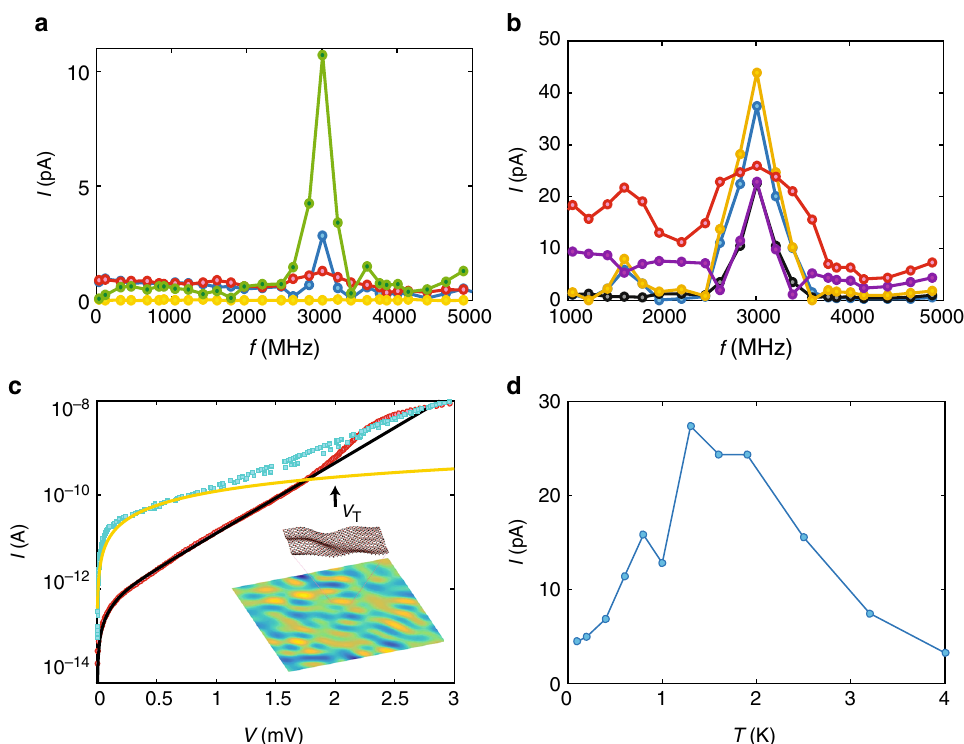
Fig. 4 Wigner crystal. a The absorption microwave spectra of the detected absolute value of the DC current I vs. irradiation frequency f for sample EV2, measured at ν = 1/3 (red), ν = 0.16 (green), ν = 0.15 (blue), and ν = 0.12 (yellow), and at magnetic fi eld B = 9 T and rf-power = − 68 dBm. An absorption resonance with a maximum response for ν = 0.16, is seen at frequency 3 GHz which is identi fi ed as a collective mode frequency in the disordered-pinned Wigner crystal phase (see text). The fl at curve at ν = 0.12 is an indication of a strongly gapped fractional quantum Hall state. b Microwave absorption spectra in terms of DC current I measured across the ν = 0.16 (at fi xed charge density, V g = 2.8 V, rf-power = − 65 dBm, B = {9 T (blue), 8.8 T (black), 8.6 T (yellow), 8.4 T (violet), 8 T (red)}). Broadening of the resonance peak is seen clearly at B = 8 T, because the WC is closest to its melting temperature